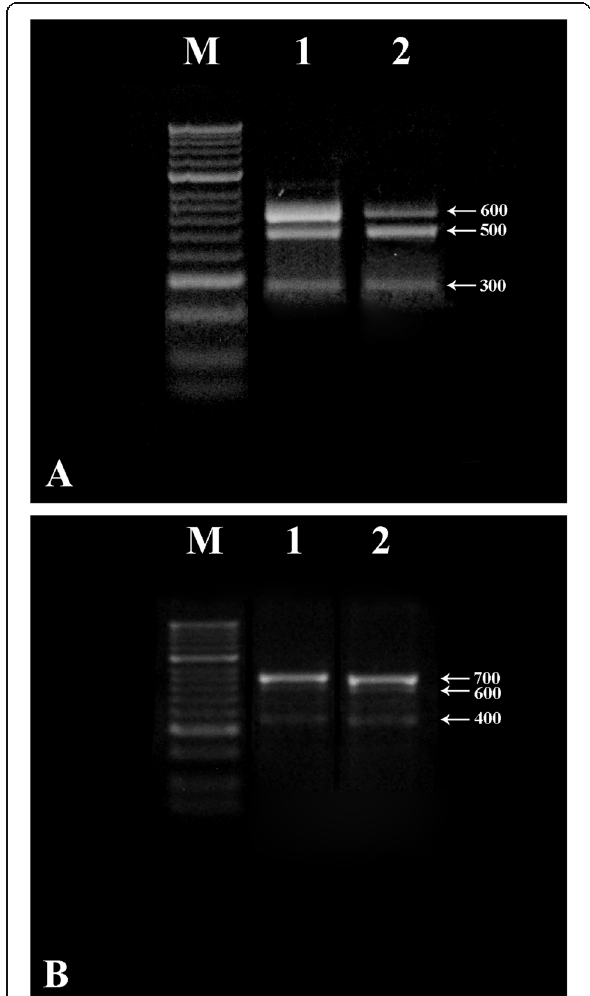
Fig. 2 a RAPD profile of in vitro regenerated and mother plants of A. alata obtained with primer OPG-03. b ISSR profile of in vitro regenerated and mother plants of A. alata obtained from primer UBC-818 [lane M — DNA maker (1 kbp ladder); lane 1 — in